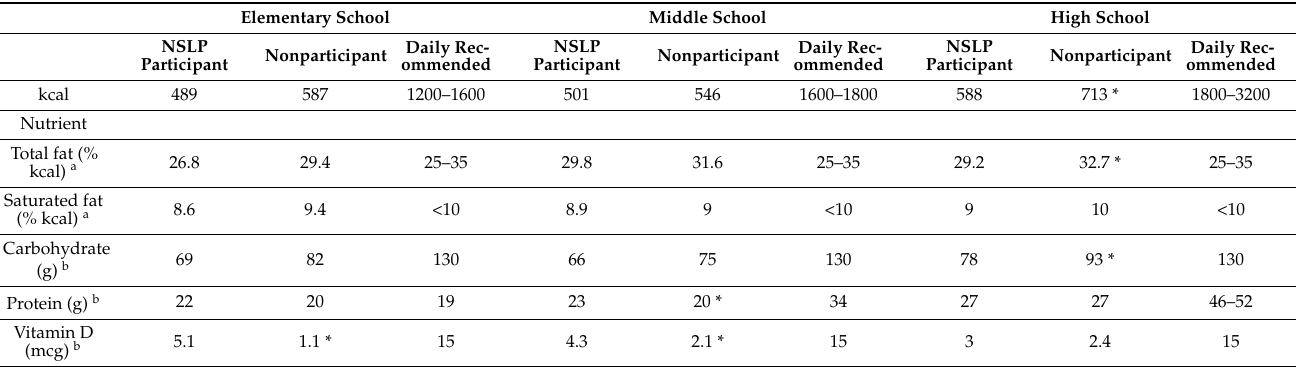
Table A1. Dietary intake at lunch, comparing National School Lunch Program participants